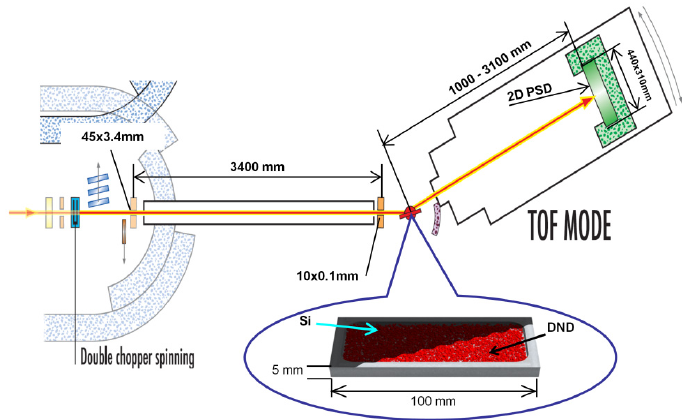
Figure 2. Top view scheme of measurements of the QSR of neutrons from the powder of NDs. The circled magnification shows a sample of ND powder (red) in a sample container. The double chopper periodically interrupts the incident neutron beam, thus providing a pulsed neutron spectrum for time-of-flight measurements. Various devices in front of the sample provide background suppression, neutron transport and neutron beam collimation. A position-sensitive 3 He detector (2D PSD) is behind the sample. The arrow illustrates a neutron quasi-specularly reflected from the sample.